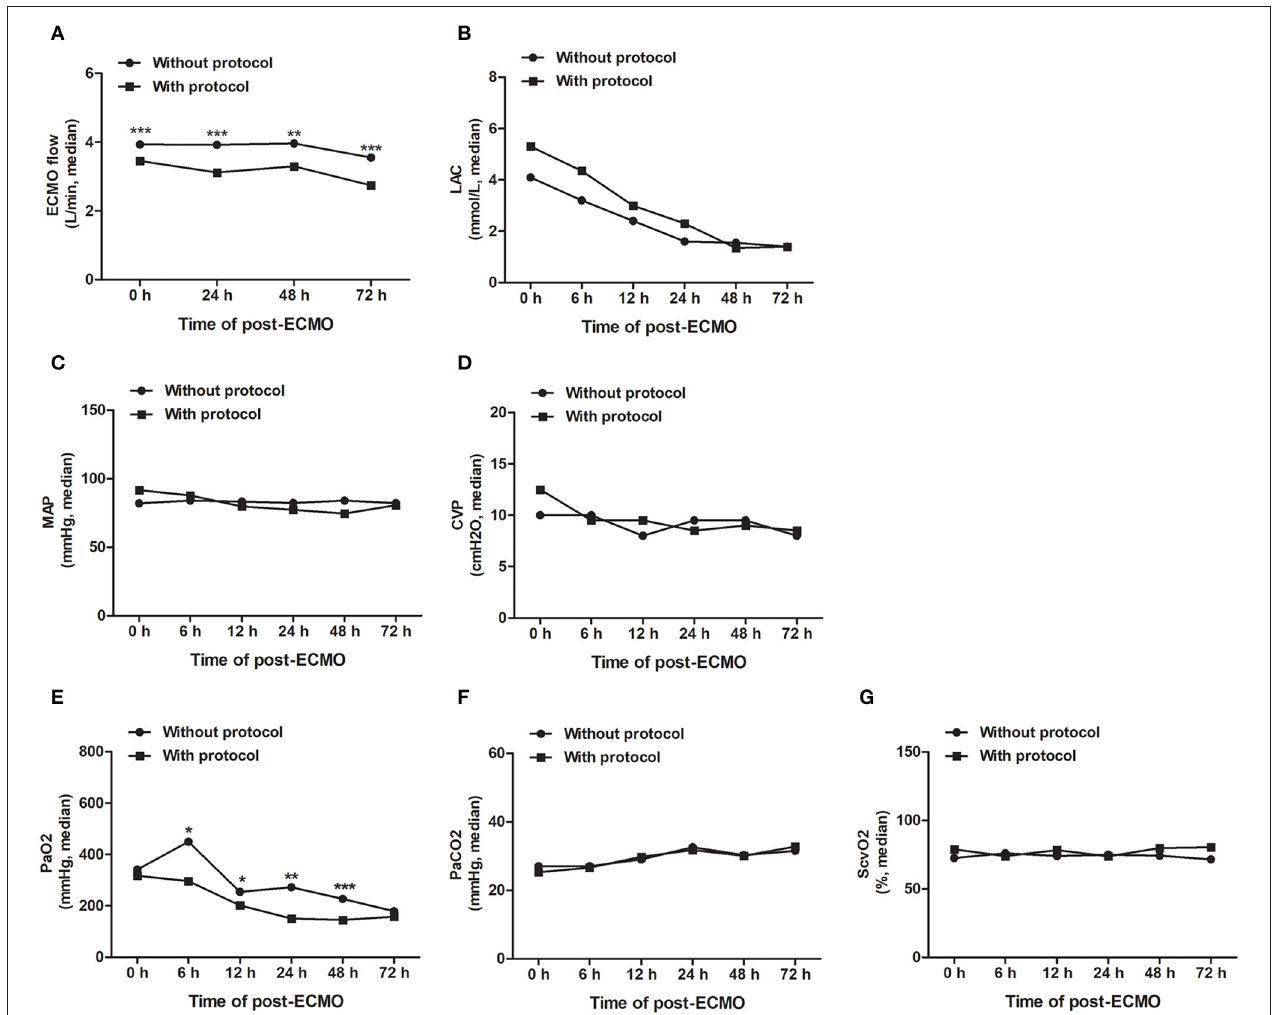
FIGURE 3 | The MNM-guided protocol improves the precision management of VA-ECMO-supported patients. Guided by the MNM protocol, we can accurately adjust the ECMO flow rate (A) , maintain appropriate afterload (MAP) and preload (CVP) (B,C) , and accelerate the removal of lactic acid (D) to achieve the oxygen delivery and consumption balance of patients (E–G) . ECMO, extracorporeal membrane oxygenation; MAP, mean arterial pressure; CVP, central venous pressure; ScvO 2 , central venous oxygen saturation; LAC, lactic acid. All data are representative of the median, and the Mann–Whitney U test was used for the comparison. *** P < 0.001, ** P < 0.01, * P <